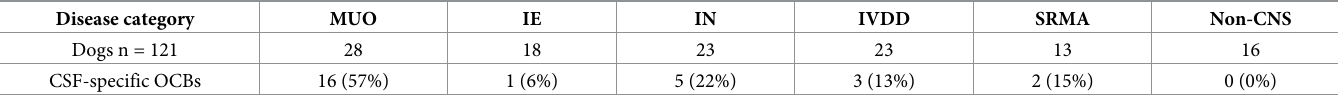
Table 2. Numbers of dogs included per disease category as well as prevalence of CSF-specific OCBs ( � 2 OCBs uniquely in CSF) per disease category. Disease